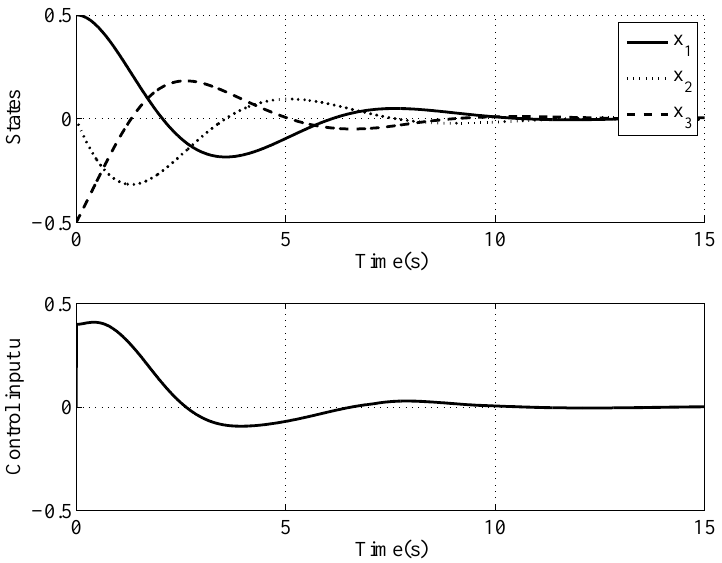
Figure 3. Initial condition response of a finite-time stabilized triple